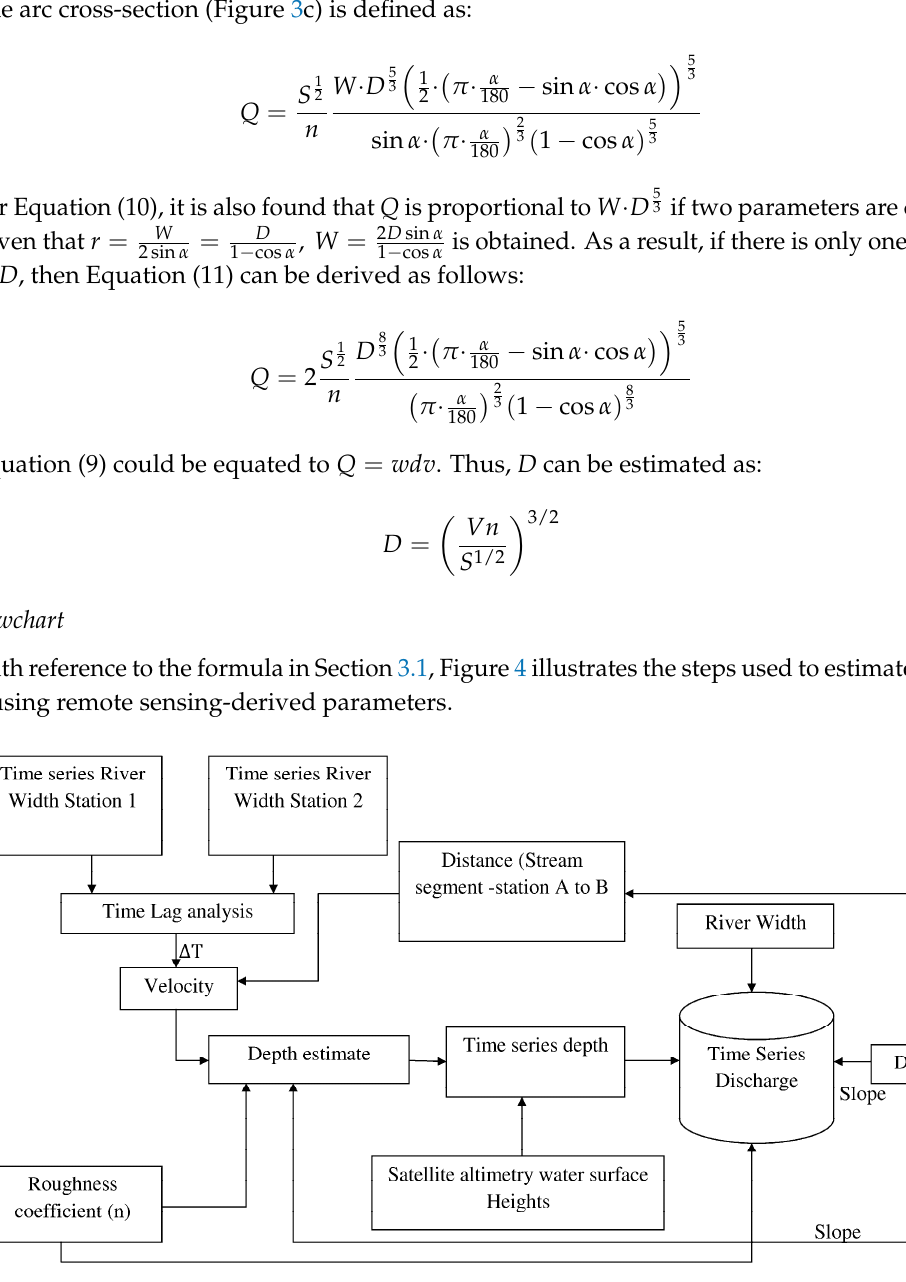
Figure 4. A flowchart to extract river discharge estimates using remote sensing-derived parameters (Equations (4), (9) and (12)).